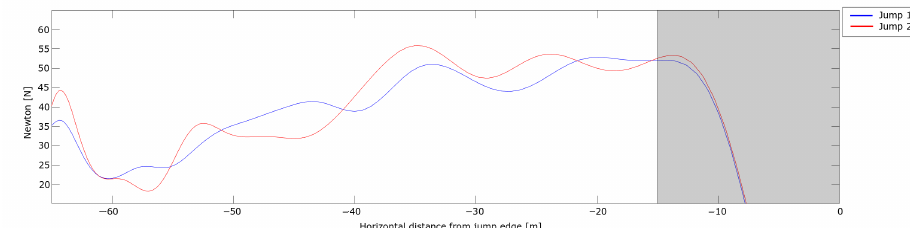
Figure 8. Braking force acting on the ski jumper during the in-run phase measured with the dGNSS. The horizontal length from the in-run edge is shown on the x-axis and velocity is shown on the y-axis.